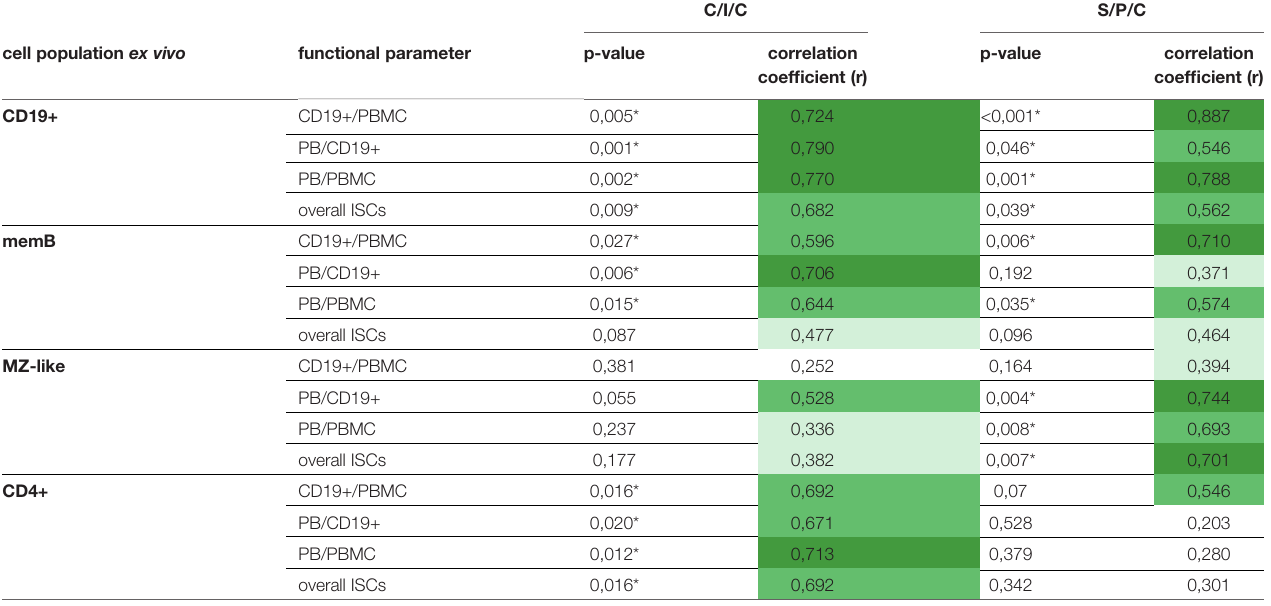
faint green: weak correlation; medium green: moderate correlation; dark green: strong correlation. The correlation coef fi cient (r) was used to divide relationships into weak (0.3<r<0.5), moderate (0.5<r<0.7) and strong (r>0.7) correlations. *p <